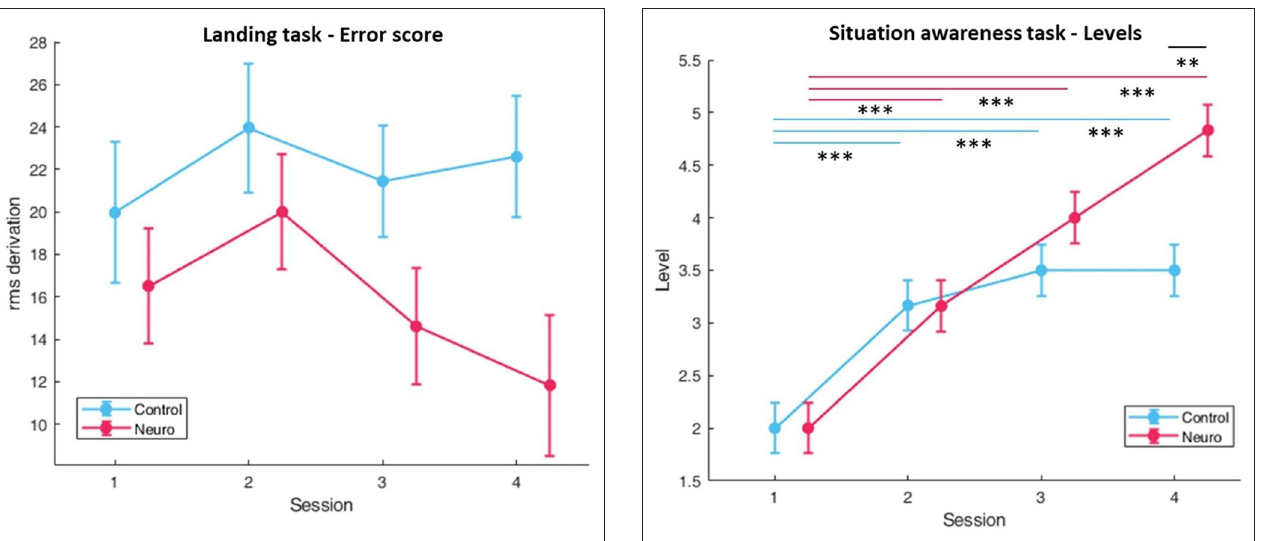
FIGURE 8 | Training levels reached for situational awareness over each session per experimental group. Neuroadaptive group reached significantly higher levels in session 4 (whiskers are SEM, ** p < 0.01, *** p < 0.001).